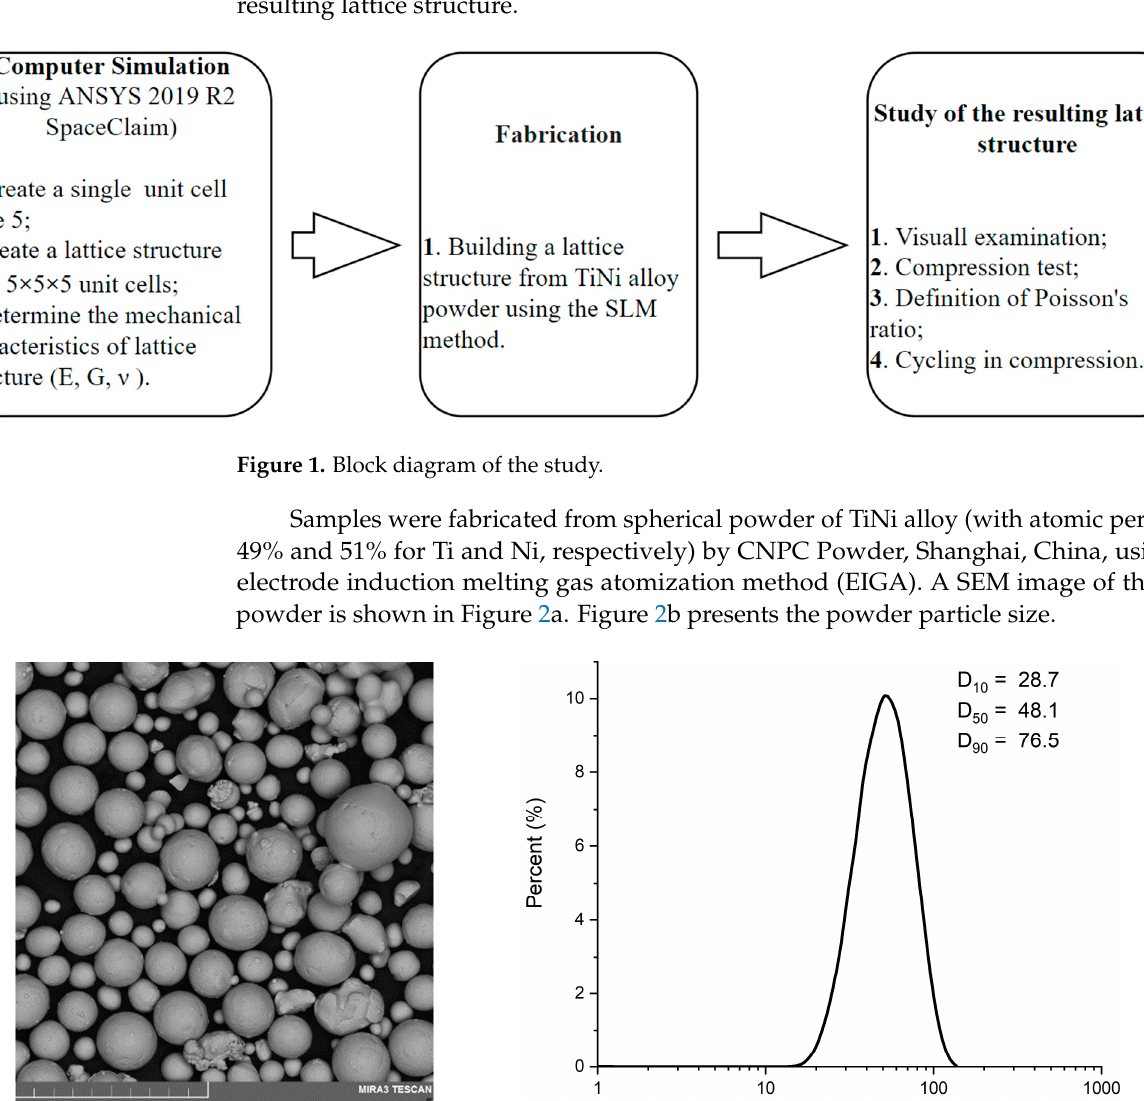
( b ) Figure 3. ( a ) Single Type5 unit cell with negative Poisson’s ratio; ( b ) Lattice structure based on a single Type 5 unit cell.